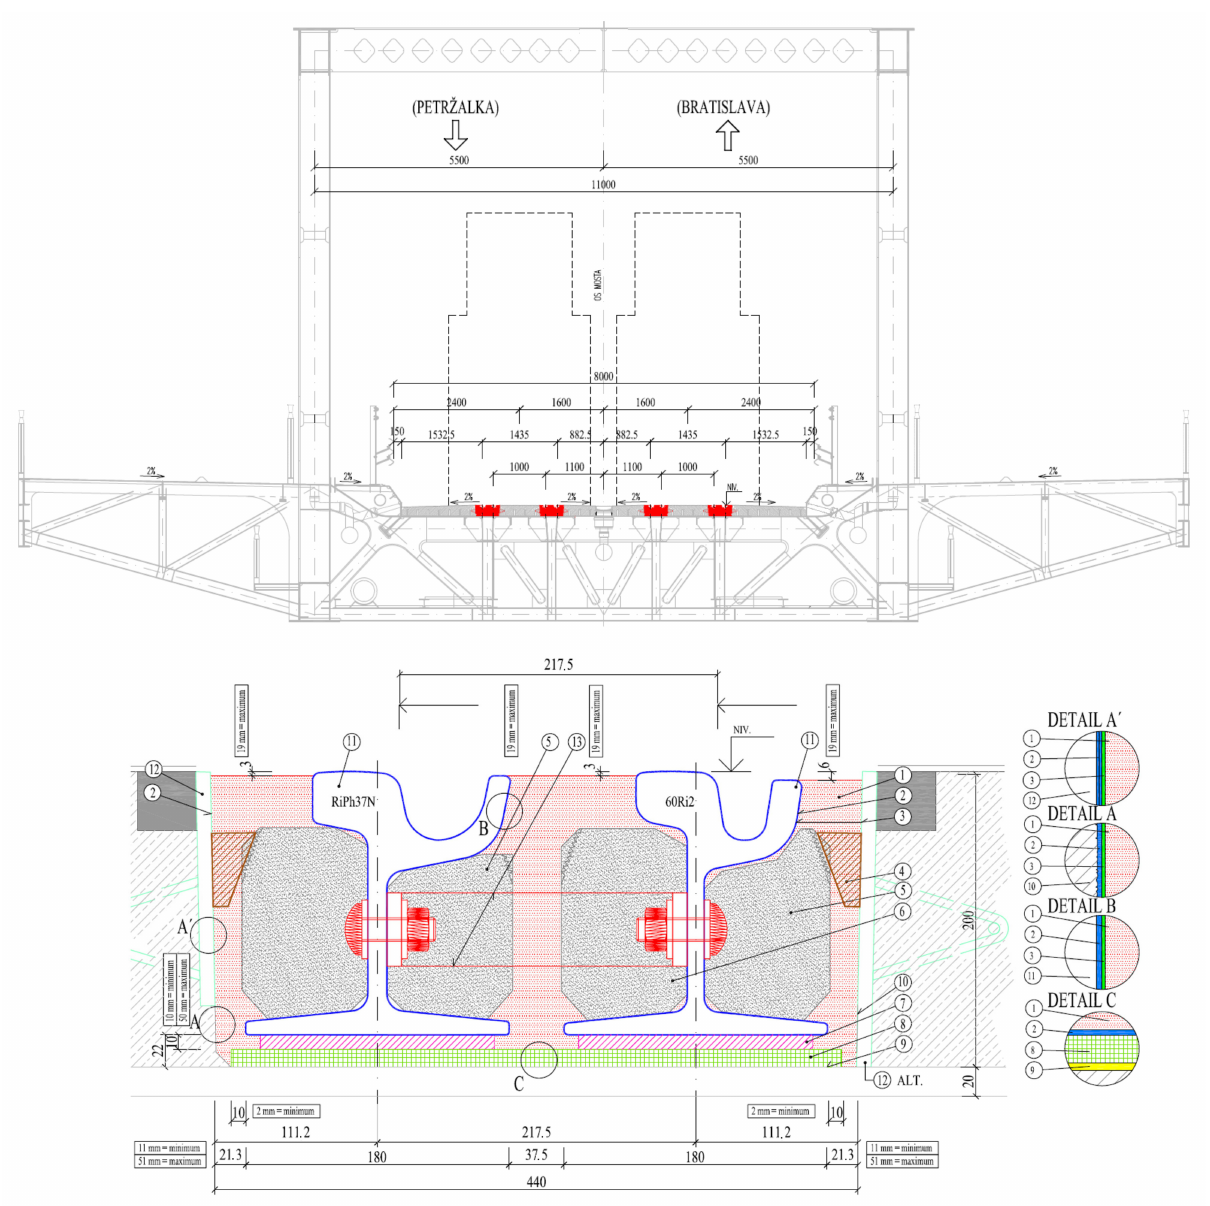
Figure 3. Schematic cross-section of the Old Bridge structure with details of the tram line super- structure, 1—EDILON Corkelast filling material, 2—EDILON Primer U90WB primer,